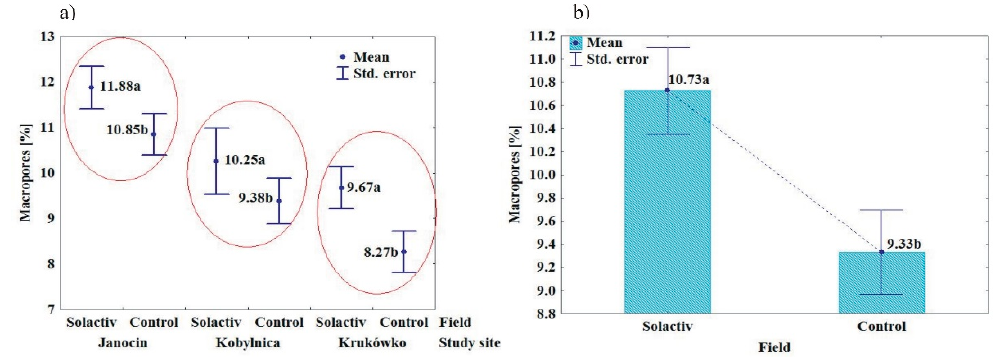
Figure 6. Soil macropores as affected by the tested conditioner. ( a ) means for individual study sites ( n = 10); ( b ) means for all study sites ( n = 30). Different small letters indicated significant differences between mean values. Data were analyzed using one-way ANOVA. Mean values for conditioner and control followed by di ff erent letters are significantly di ff erent at p ≤ 0.05 according to Tukey’s HSD